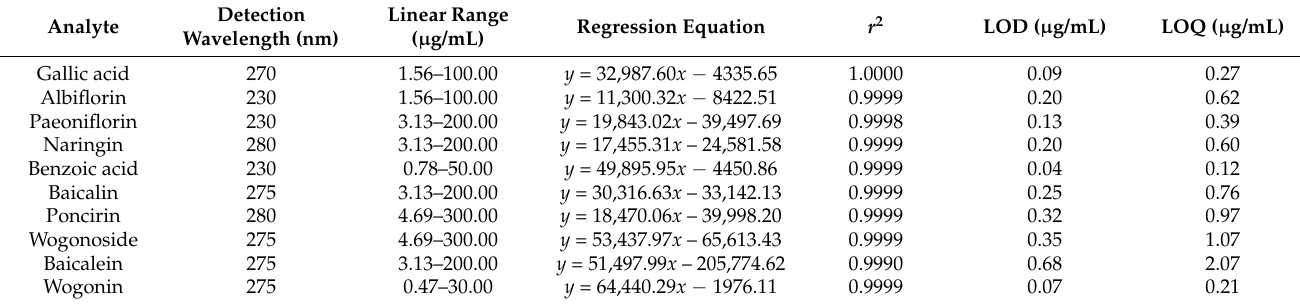
Table 1. Linear range, regression equation, r 2 , LOD, and LOQ of the 10 markers for simultaneous analysis by HPLC ( n = 3).